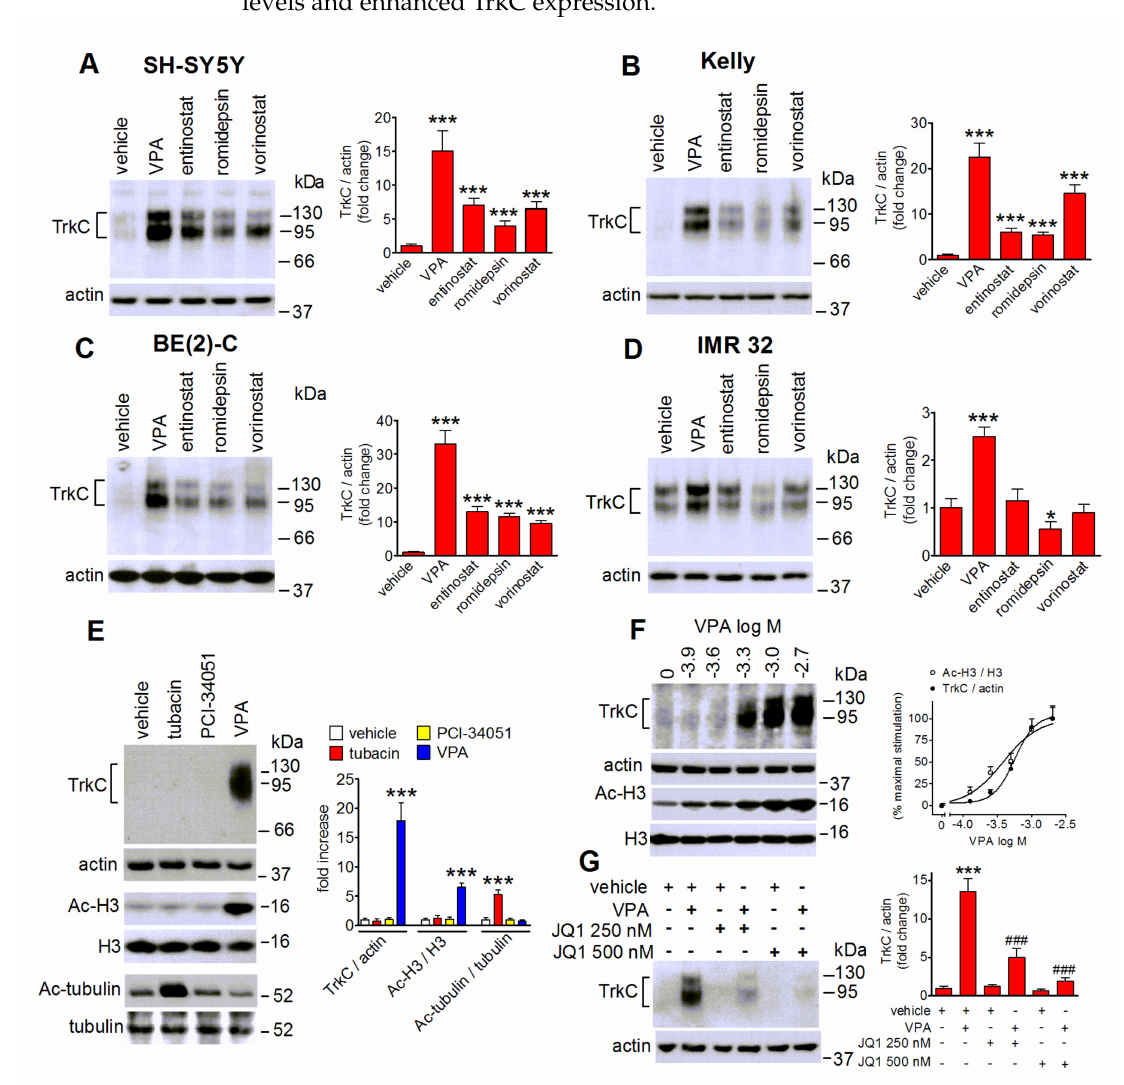
Figure 3. Effects of HDAC and BET inhibitors on TrkC expression in human neuroblastoma cells. ( A – D ) Cells were incubated for 24 h with either vehicle, 1 mM VPA, 1 µ M entinostat, 20 nM romidepsin or 200 nM vorinostat. Cell lysates were analyzed for TrkC expression by Western blot. Values are the mean ± SD of four independent experiments. * p < 0.05 *** p < 0.001 vs control (vehicle). ( E ) SH-SY5Y cells were treated for 24 h with either vehicle, 5 µ M tubacin, 5 µ M PCI-34051 or 1 mM VPA. Cell lysates were analyzed for TrkC, actin, acetyl-Lys9/Lys14 histone H3 (Ac-H3), H3, acetyl-tubulin (Ac-tubulin) and tubulin. Densitometric ratios are reported as fold increase with respect to control (vehicle) and are the mean ± SD of four independent experiments. *** p < 0.001 vs the corresponding control (vehicle). ( F ) SH-SY5Y cells were incubated for 24 h with the indicated concentrations of VPA. Cell lysates were analyzed for TrkC expression and histone H3 acetylation. Values are the mean ± SD of four independent experiments. ( G ) SH-SY5Y cells were preincubated for 1 h with either vehicle, 250 nM or 500 nM (+)-JQ1 (JQ1) and then treated with either vehicle or 1 mM VPA for 24 h. Cell lysates were analyzed for TrkC expression. Values are the mean ± SD of four independent experiments. *** p < 0.001 vs. control (vehicle + vehicle); ### p < 0.001 vs. vehicle + VPA by ANOVA followed by Tukey’s